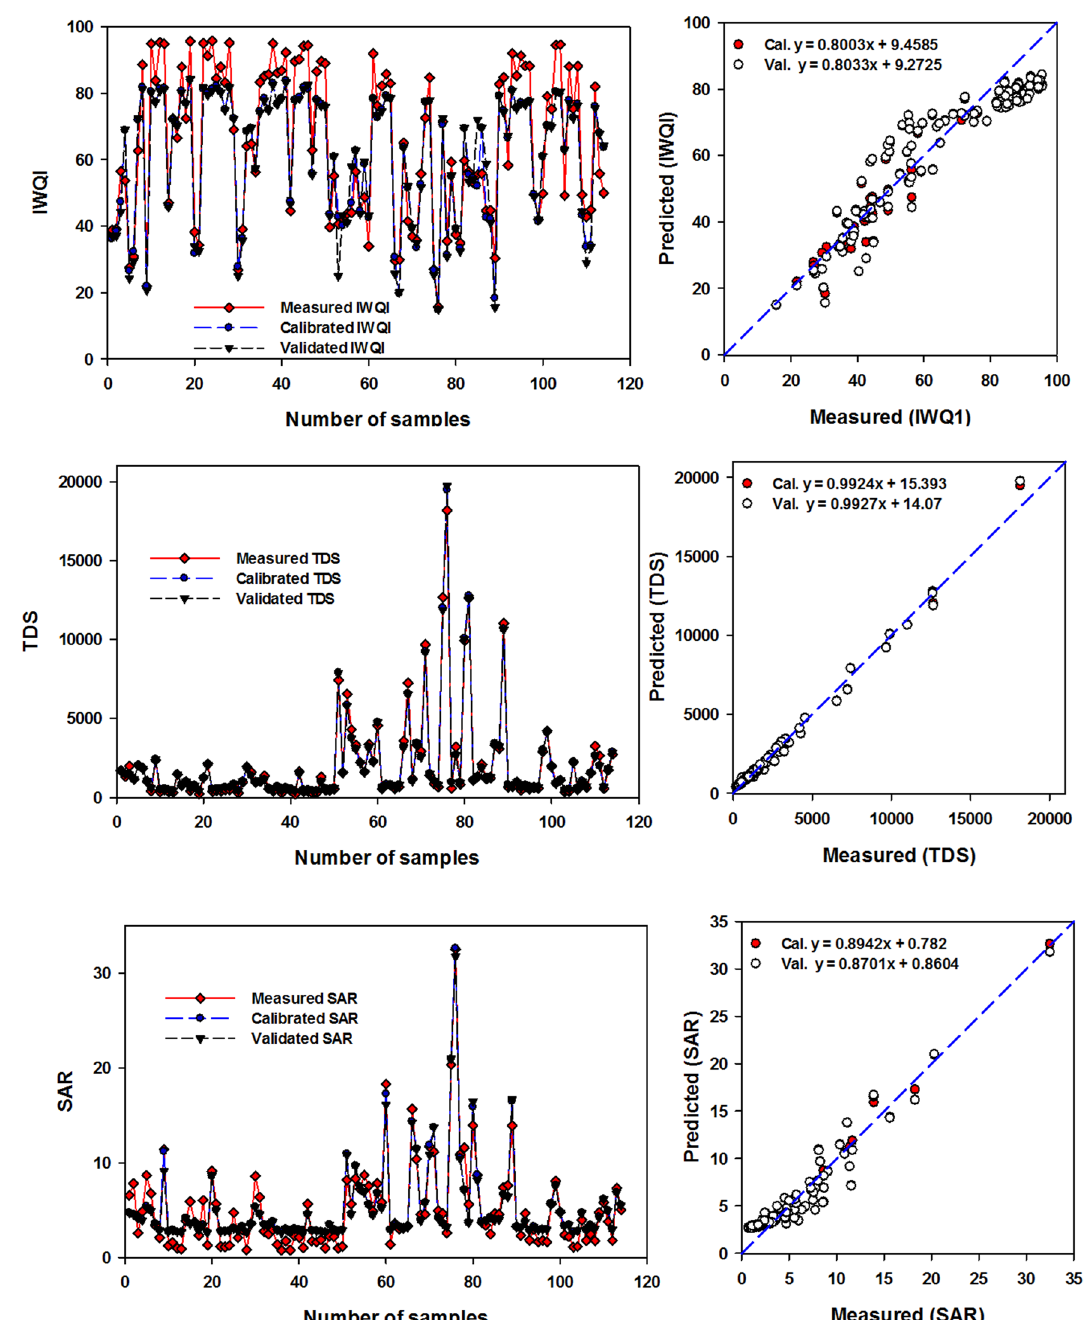
Fig. 12 Results of the comparison between measured, calibrated, and validated datasets for IWQI, TDS, and